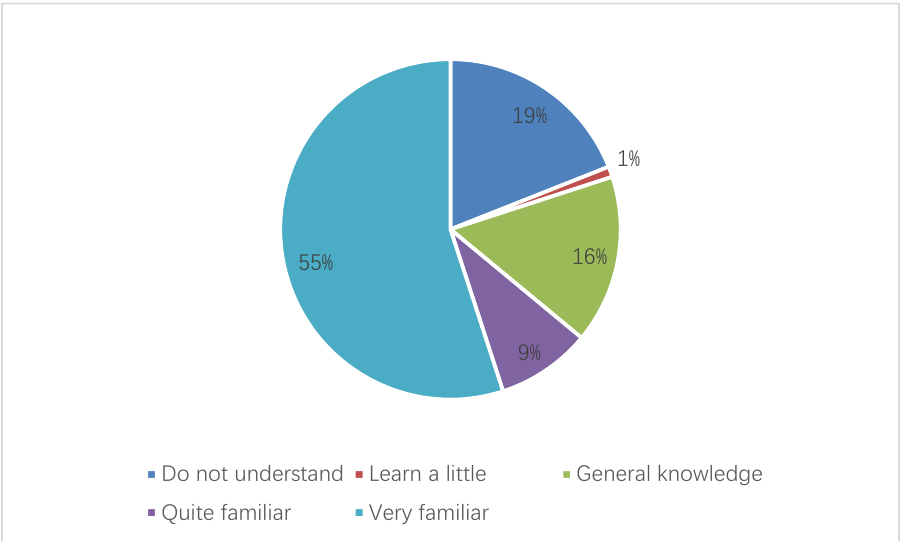
Figure 12. Consumers’ understanding of organic agricultural products.